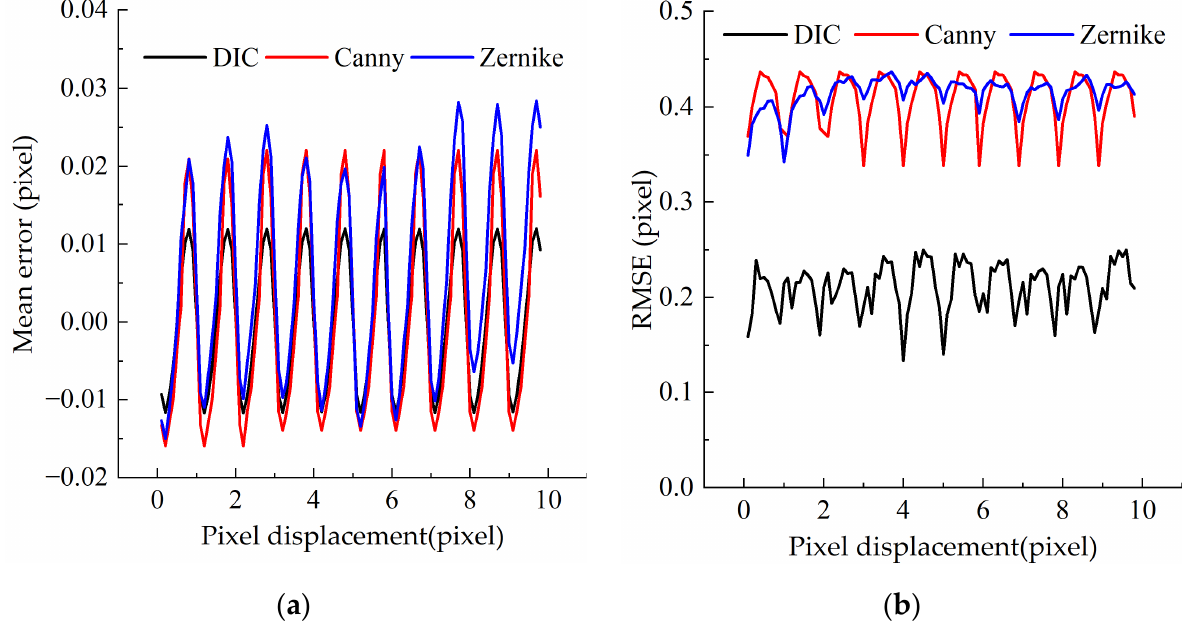
Figure 7. Performance evaluation of simulation experiment algorithm: ( a ) displacement—error mean diagram; and ( b ) displacement-error mean square diagram.